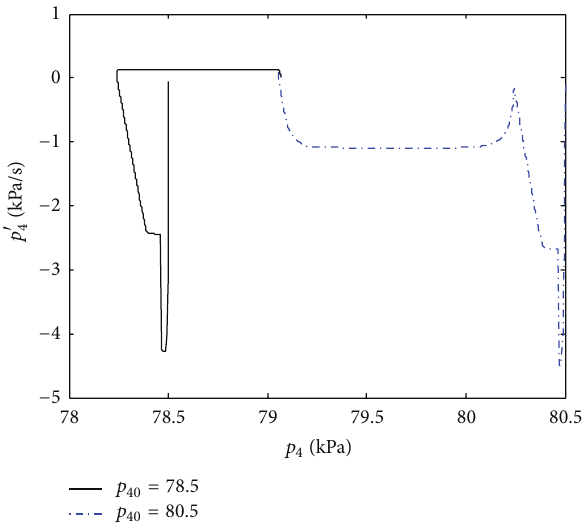
Figure 7: Simulation result of cabin pressure 𝑝 4